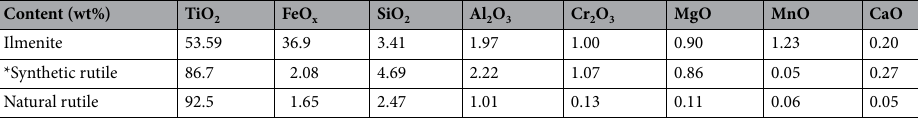
Table 1. Chemical compositions of ilmenite, synthetic rutile, and natural rutile (wt%). *Synthetic rutile: obtained by selective chlorination from ilmenite (after 40 min at 1173